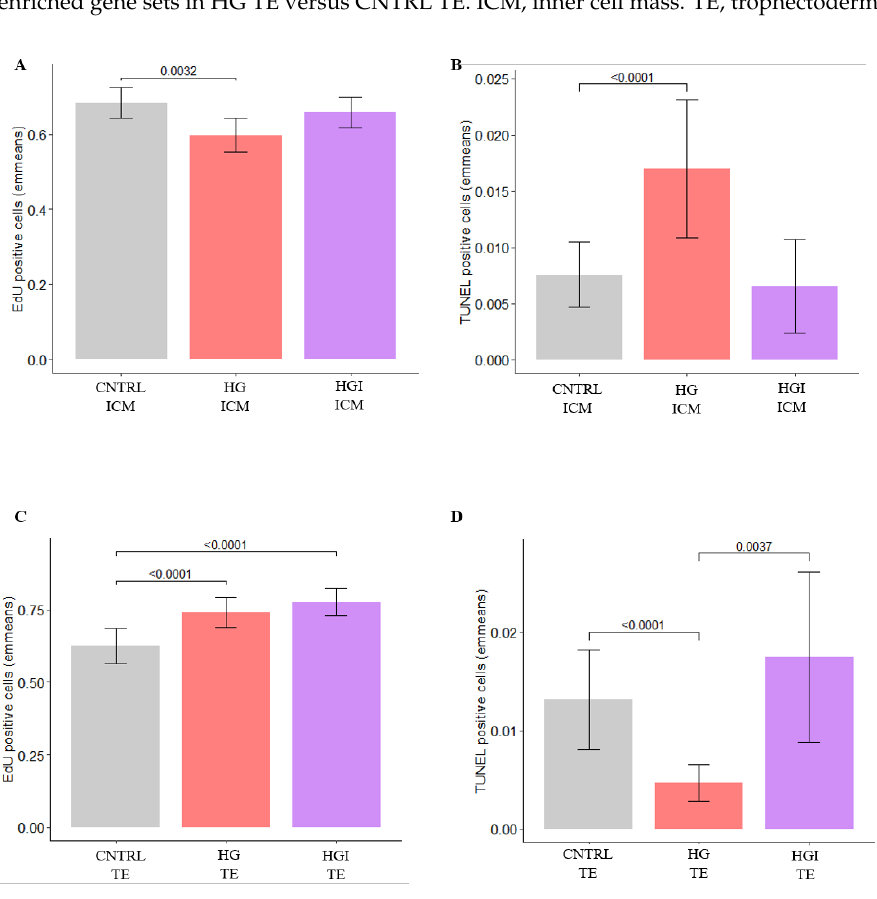
Figure 6. Quantification of proliferating and apoptotic cells in the ICM and TE of in-vitro-developed blastocysts with CNTRL, HG, and HGI by EdU incorporation and TUNEL assays. ( A ) Barplots showing the emmeans of proliferating cells in the ICM (n ICM = 16–38). ( B ) Barplots showing the emmeans percentage of apoptotic cells in the ICM (n ICM = 13–59). ( C ) Barplots showing the emmeans of proliferating cells in the TE (n TE = 16 – 24). ( D ) Barplots showing the emmeans of apoptotic cells in the TE (n TE = 18 – 52). Values are presented as emmeans ± S.E. Significant p values ( p < 0.05) are shown. ICM, inner cell mass. TE, trophectoderm; CNTRL, control; HG, high glucose; HGI, high glucose and high insulin. In addition to the main clusters, HG ICM transcriptomes showed perturbations in signaling pathways. HG ICM showed the overexpression of REL (REL proto-oncogene, NF-kB subunit, log2FC = 2.18) and the enrichment of gene sets related to NF-kB signaling, such as Reactome “FCERI mediated NF - kB activation” (NE S = 1.84) (Supplementary Ta- bles S1 and S2). Differential and enrichment analyses also showed dysregulations in the WNT signaling pathway. These results included the downregulation of APC (log2FC = −0 .67) (Supplementary Table S 1) and enrichment of Reactome “degradation of β -catenin by the destruction complex” (NE S = 1.73) (Supplementary Table S2). Furthermore, gene- by-gene analysis of the HG ICM DEG revealed the overexpression of genes involved in the trophoblast lineage, such as GATA binding protein 3 ( GATA3 , log2FC = 1.05) and pla- centa expressed transcript 1 ( PLET1 , log2FC = 2.39) (Figure 7 and Supplementary Table S1).